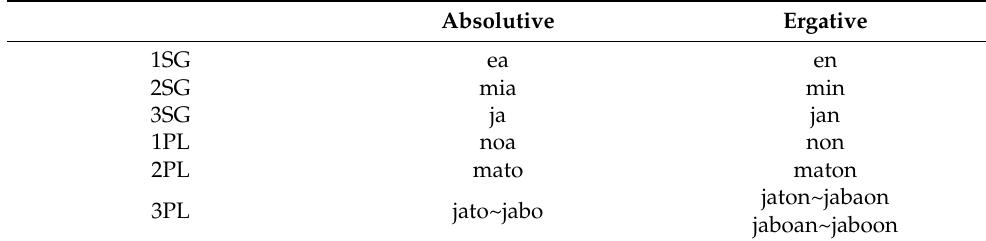
Table 2. Shipibo-Konibo personal pronouns (adapted from Valenzuela 2003, p.